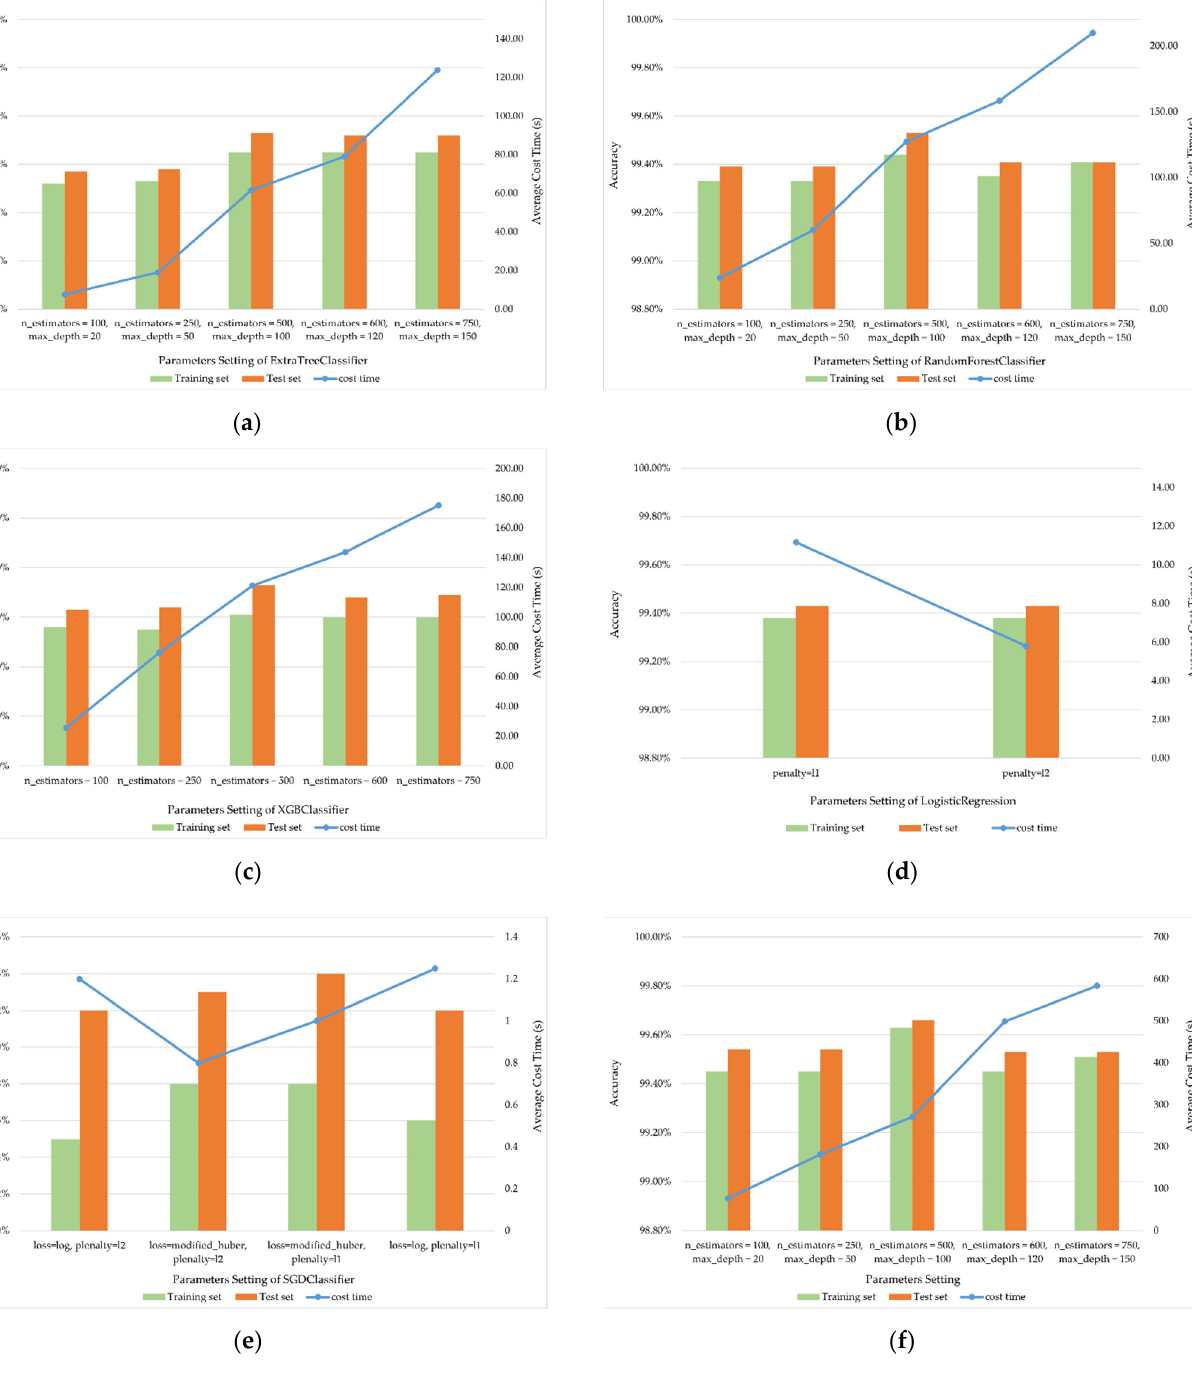
Figure 17. The influence of parameters on training accuracy and time-consuming ( a ) performance of ExtraTreeClassifier; ( b ) performance of RandomForestClassifier; ( c ) performance of XGBClassifier; ( d ) performance of LogisticRegression; ( e ) performance of SGDClassifier; ( f ) performance of synthesis model.